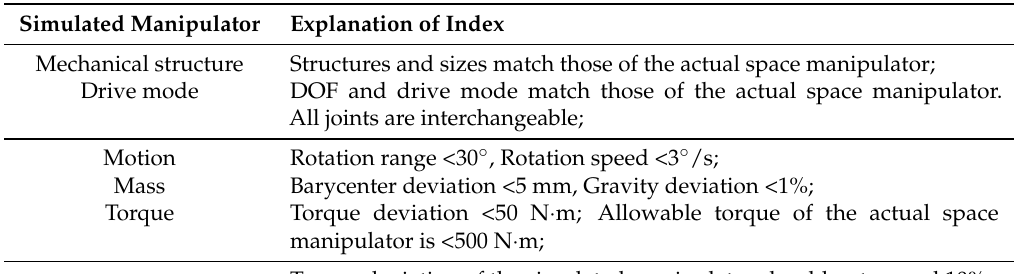
Table 1. Indices of the simulated